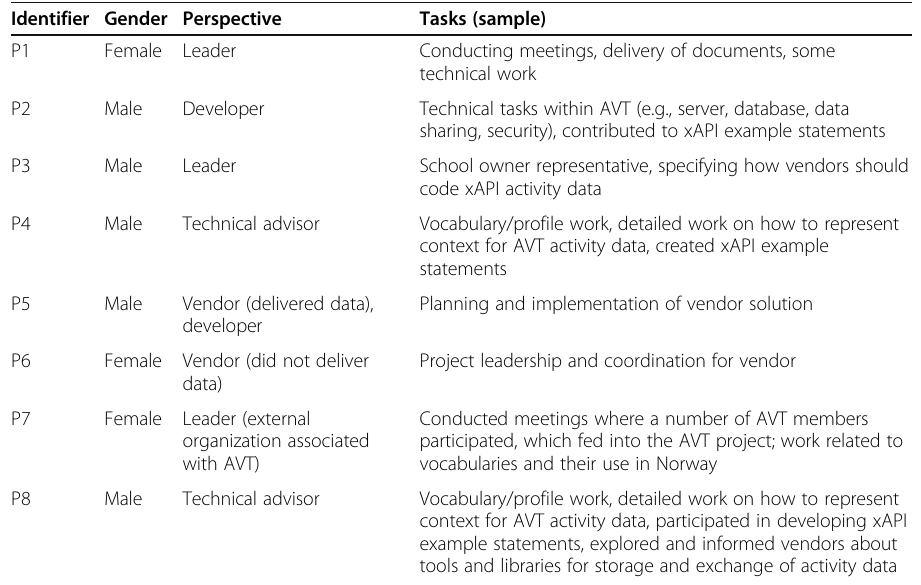
Table 3 Participants, sorted by interview